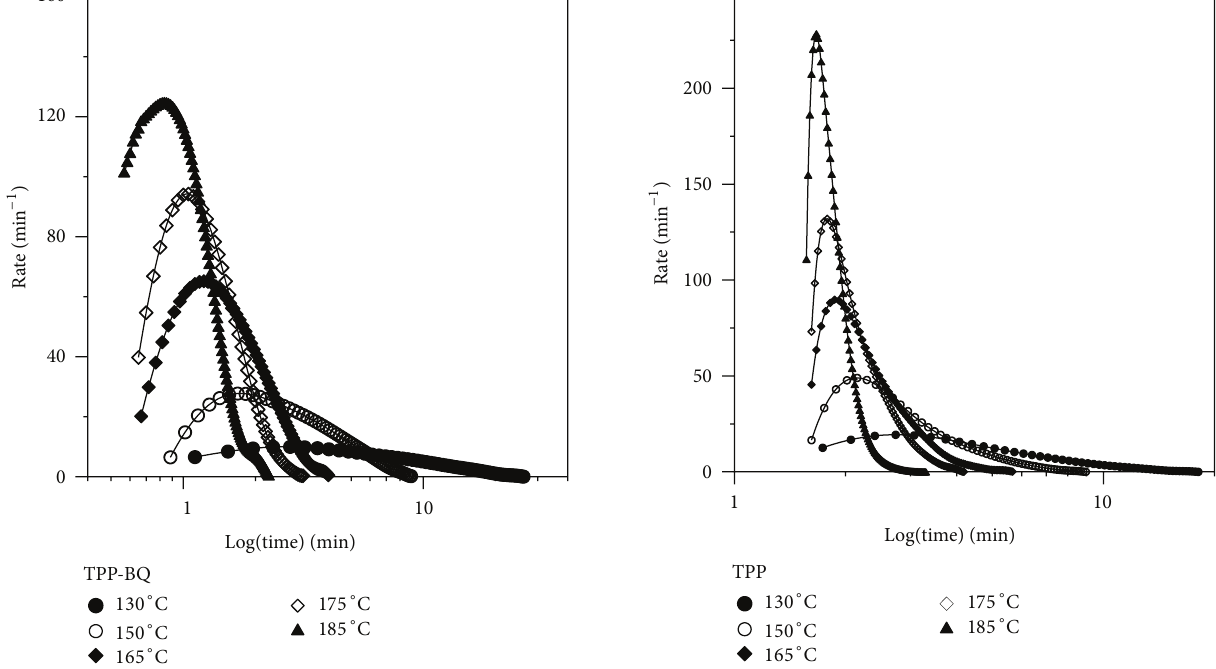
Figure 1: Plots of the reaction rate versus time for TPP-BQ-cured EMCs at isothermal temperatures.